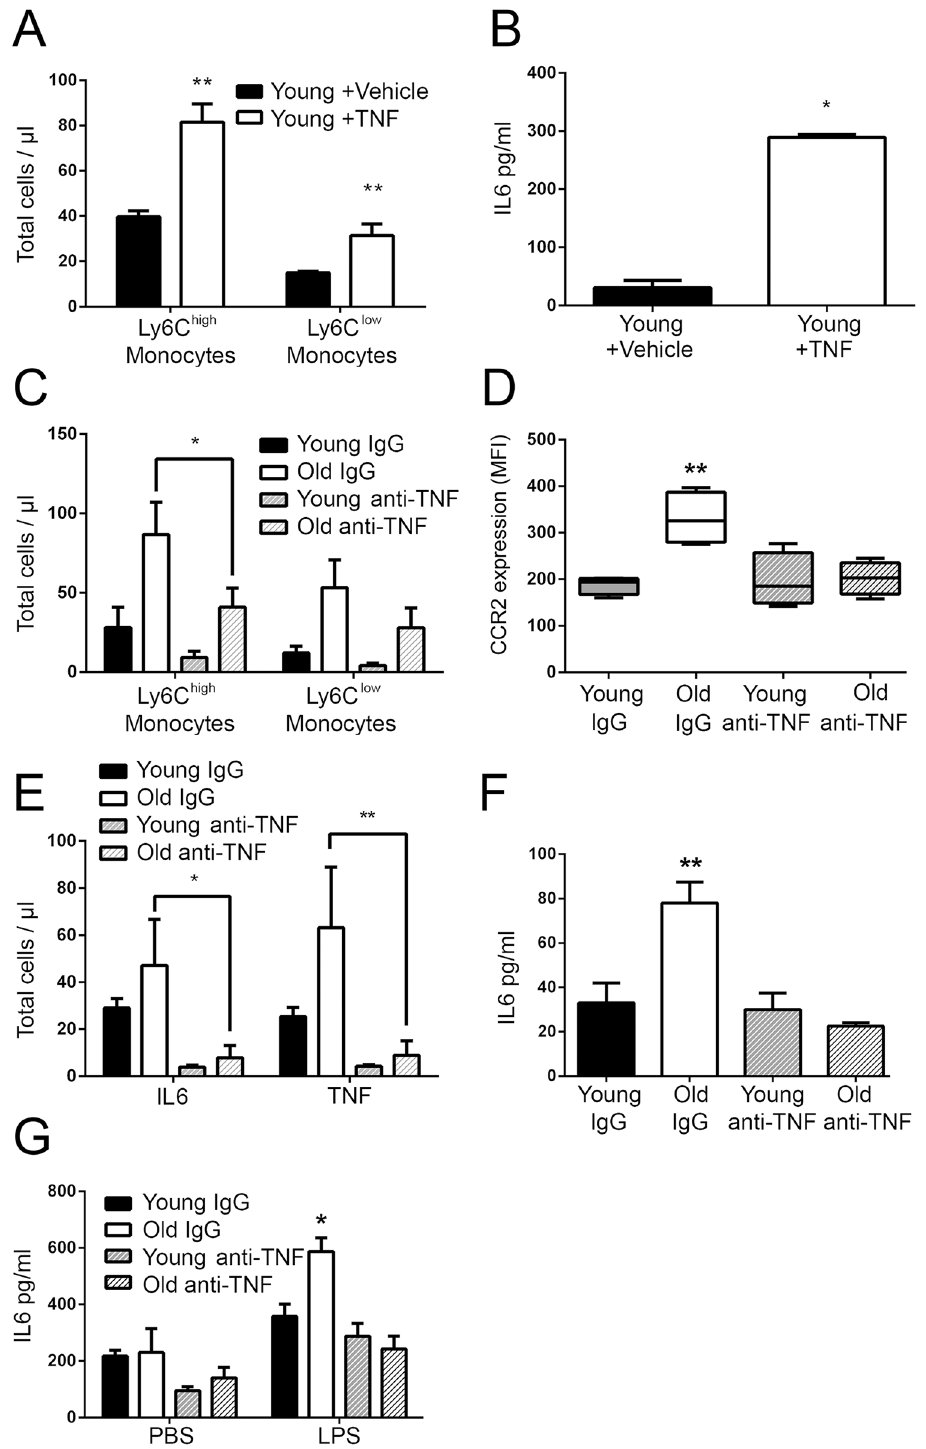
Fig 5. Anti-TNF therapy can reverse the age-associated increase in circulating Ly6C high monocytes. (A-B) Young mice were give 200 ng/ml of TNF intraperitoneally every other day for 3 weeks. Numbers of circulating Ly6C high and Ly6C low monocytes (A) and serum IL6 (B) were quantitated. The data represent the mean ( ± SEM) of 5 mice. (C) Young and old WT mice were treated for 3 weeks with a neutralizing TNF antibody or IgG control and total numbers of circulating Ly6C high monocytes were quantitated by